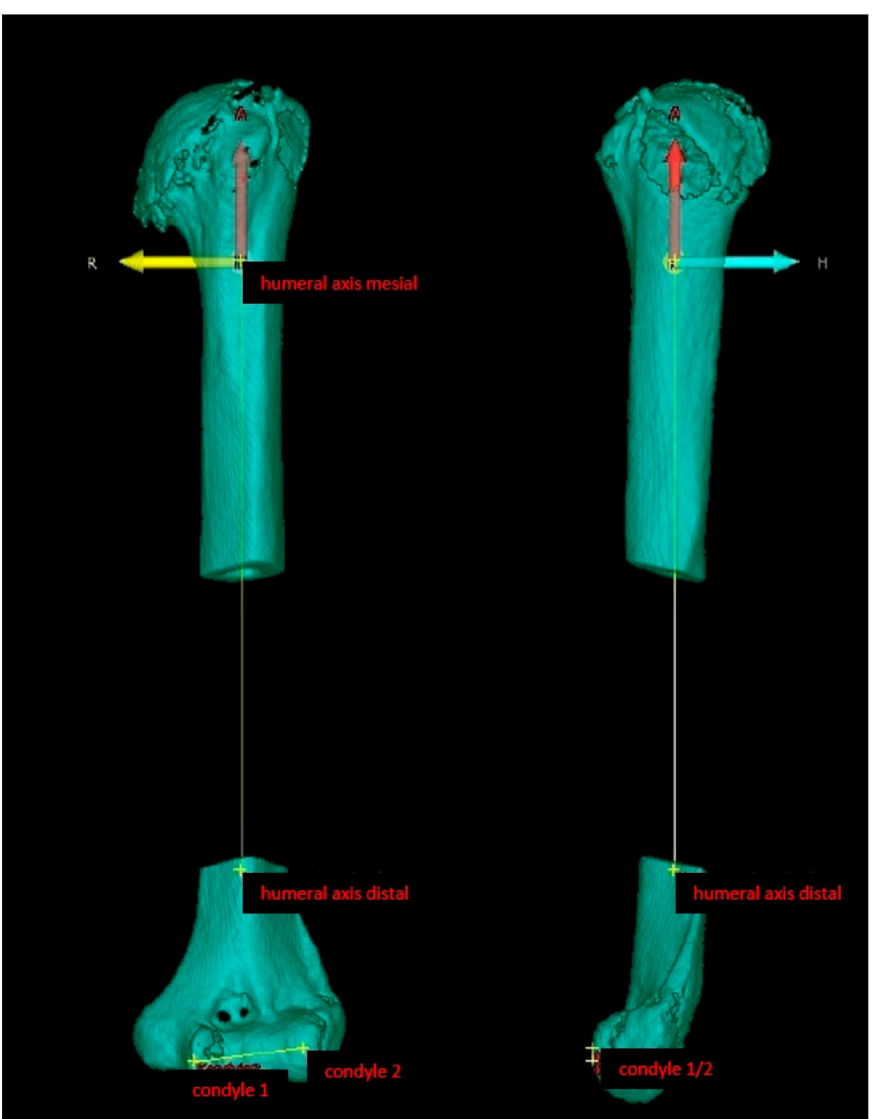
Figure 1. Creation of a humeral coordinate system with the condyle–humeral axis as a standardized